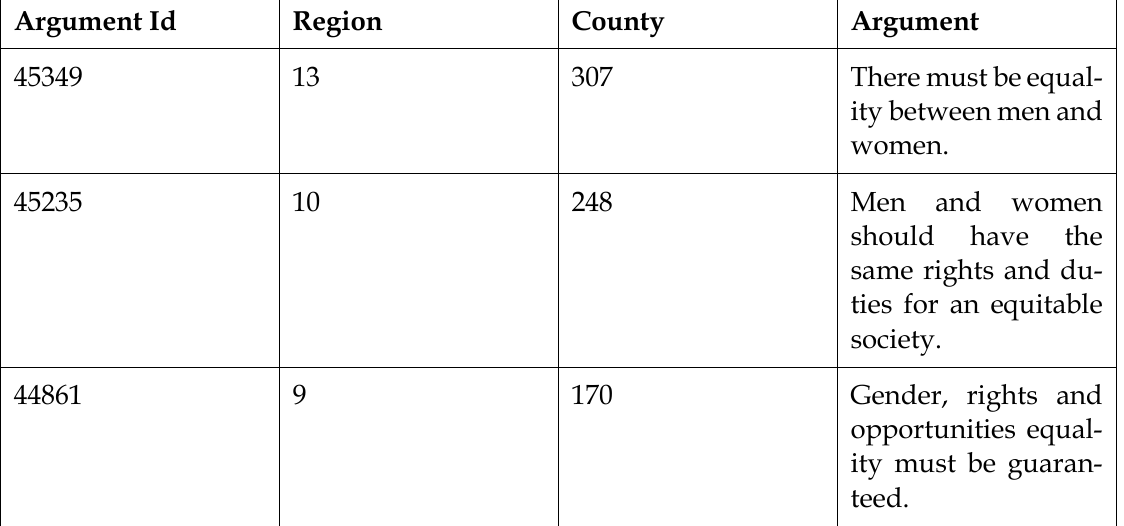
Table A1: Database extract Argument Id